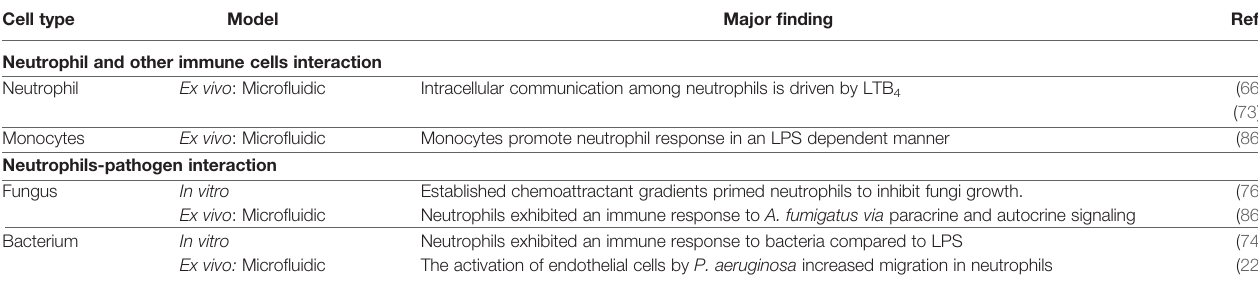
TABLE 4 | Summary of studies on neutrophil interaction with other immune cells. Cell